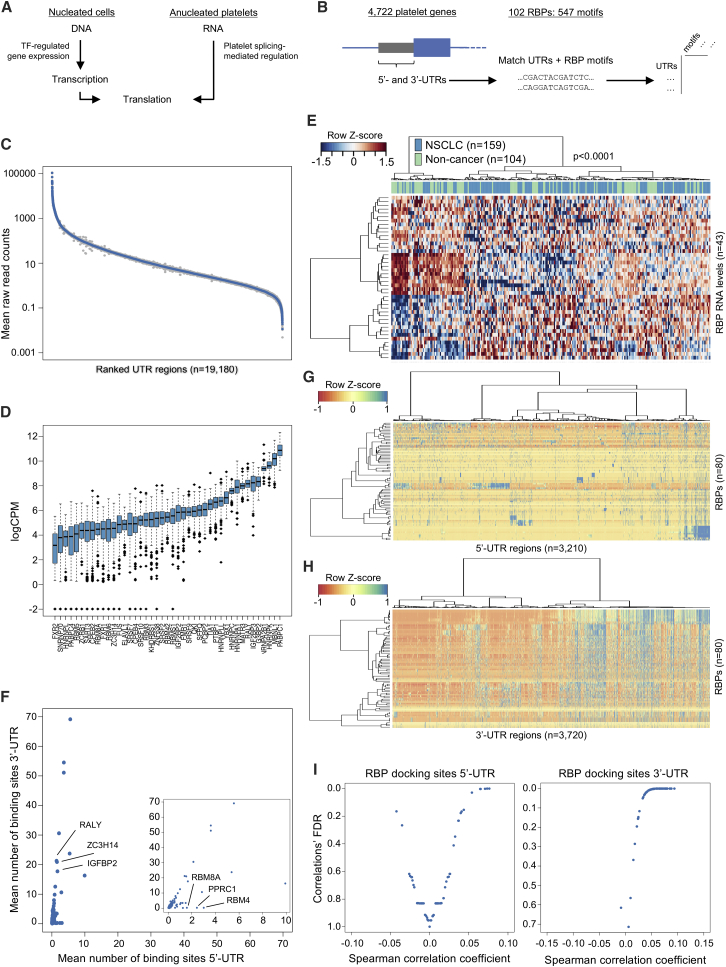
RNA-Binding Protein Analysis of TEP-Derived RNA Signatures(A) Schematic biological model highlighting the difference between nucleated cells and anucleated platelets in the context of regulation of translation. Nucleated cells (left) are able to regulate and maintain the transcriptome by transcription factor (TF)-mediated DNA transcription, in contrast to platelets.(B) Schematic representation of the RNA-binding protein (RBP)-thromboSearch engine algorithm. Reference genome sequences from 4,722 platelet genes were matched with 547 motif sequences deconvoluted from 102 RBPs.(C) UTR-read coverage filter. Blue dots represent mean counts across all samples, and gray shading indicates the respective standard deviations.(D) Boxplots indicate the average RBP RNA expression levels (n = 43 RBPs identified) in log2-transformed counts-per-million (logCPM) sorted by median normalized intron-spanning read level. The boxes of the boxplots indicate the IQR, the horizontal black line indicates the median values, and the whiskers range 1.5× the IQR.(E) Heatmap with unsupervised clustering of RNA levels from 43 RBPs in the age, smoking status, and blood storage time-matched cohort (n = 263 samples; n = 104 non-cancer, n = 159 NSCLC). The RBP RNA levels enable non-random clustering of the samples (p < 0.0001, n = 263, Fisher's exact test).(F) Enrichment of identified RBP binding sites per UTR region. The x and y axes represent the mean binding sites for the 5′ and 3′ UTR per RBP (dots, n = 80). Several RBPs are specifically enriched in the 3′ UTR, whereas others are enriched in the 5′ UTR.(G and H) Heatmap of all RBPs (rows) and all 5′ UTR (G) and 3′ UTR (H) regions detected with sufficient coverage in platelets (column). Number of binding sites is indicated in the color coding.(I) Spearman's rank correlation analysis between n binding sites of an RBP and the logarithmic fold-change (logFC) of genes in the NSCLC/non-cancer differential splicing analysis. Positive correlations indicate an enrichment in binding sites with an increase of the logFC, whereas negative correlations indicate the opposite. Plots indicate the relation between the Spearman's correlation coefficient (x axis) and the concomitant differential splicing FDR value.